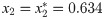
Evolutionary branching and evolutionarily stable coexistence of prey species.(a) Traits coevolution plot when a2 = 3.8. The vector fields obtained from deterministic Model (9) indicate directions of coevolution of traits x1 and x2. The black curve and red curve indicate respectively isoclines of traits x1 and x2. The solid curves indicate evolutionarily singular strategies which are evolutionarily stable, while the dashed curves indicate evolutionarily singular strategies which are not evolutionarily stable. The grey region is feasible phenotype space, in which predator-prey coevolution can occur. (b) Pairwise invasibility plot (PIP) for fixed predator strategy x2=x2*=0.634. (c) Mutual invasibility plot (MIP) for fixed predator strategy x2=x2*=0.634. (d) Simulated evolutionary tree obtained through simulation of Models (9) and (23) with initial condition (x1, x2) = (0.3, 0.8) and a2 = 3.8. (e) Fitness landscape plots when (x11*,x12*,x2*)=(0.615,0.105,0.639) and a2 = 3.8. (f) Equilibrium population densities of prey species along the coevolutionary trajectory. The red curve indicates total equilibrium population density of the two prey species. (g) Equilibrium population density of predator species along the coevolutionary trajectory. Parameter values: μ1 = μ2 = μ11 = μ12 = 0.03, σ1 = σ2 = σ11 = σ12 = 0.03. The other parameter values are the same as described in Figs 1 and 2.